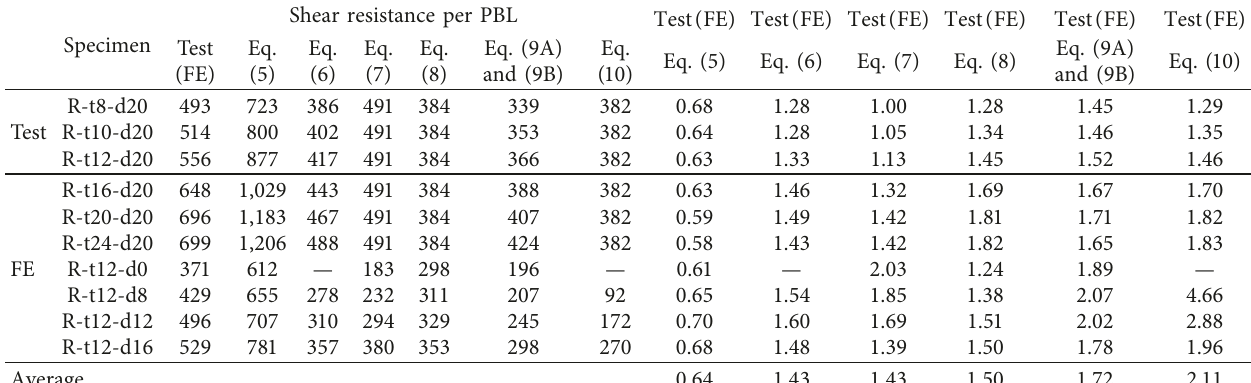
Table 5: Comparisons between experimental and predicted